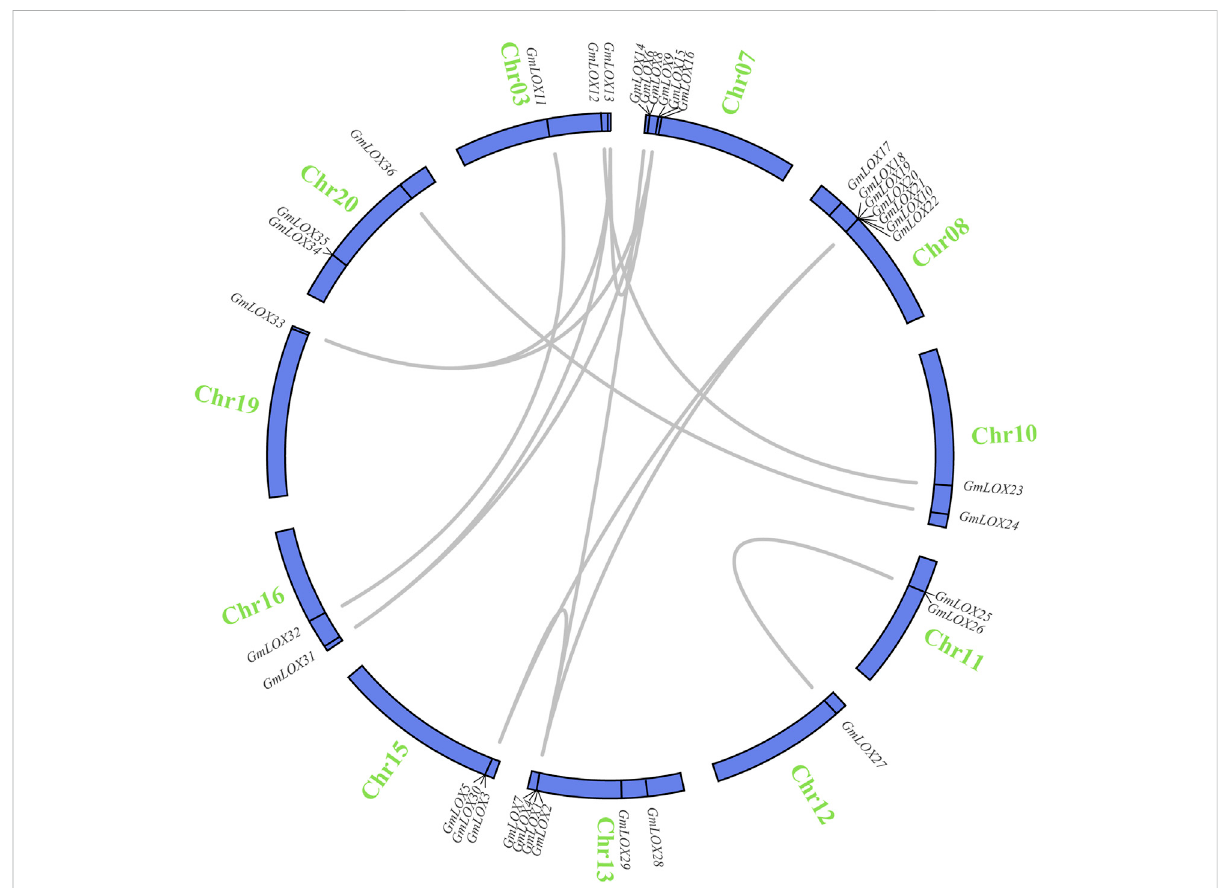
FIGURE 6 Circle plot of segmental duplicated gene pairs of GmLOX genes on chromosomes of Zhonghuang 13 Note: The blue circle bars represent chromosomes. Chromosome numbers are located outside the bar in green. The genes connected by the grey line are deplication gene